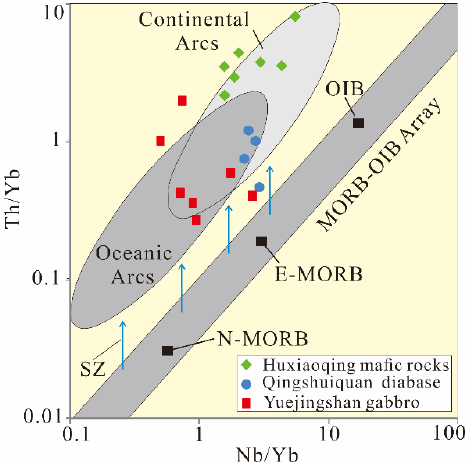
Figure 10. Th/Yb versus Nb/Yb diagram for Yuejingshan gabbro samples (modified from Pearce [83]). Data of Huxiaoqing mafic rocks originate from Liu, Ma [10]; data of Early Devonian postcollision extension mafic rocks originate from Liu, Ma [57].